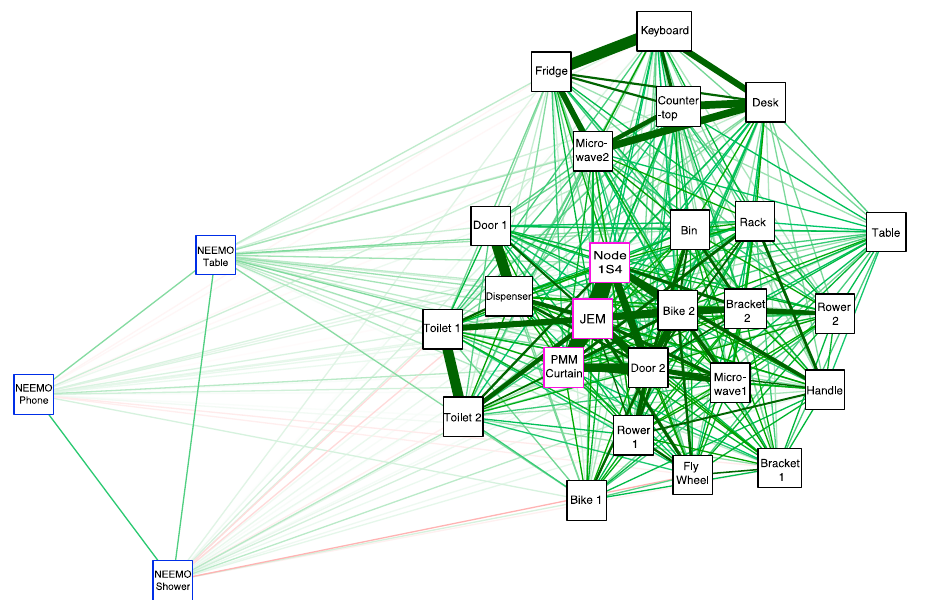
Figure 6. Spearman correlation network showing the associations between swabs collected onboard the ISS (outlined in pink) from the Aquarius Habitat on the seafloor (outlined in blue) and from the Human Health and Performance Laboratory building at the NASA Johnson Space Center (outlined in black). Sample association shown from high to low with green to red color and thick to thin lines.